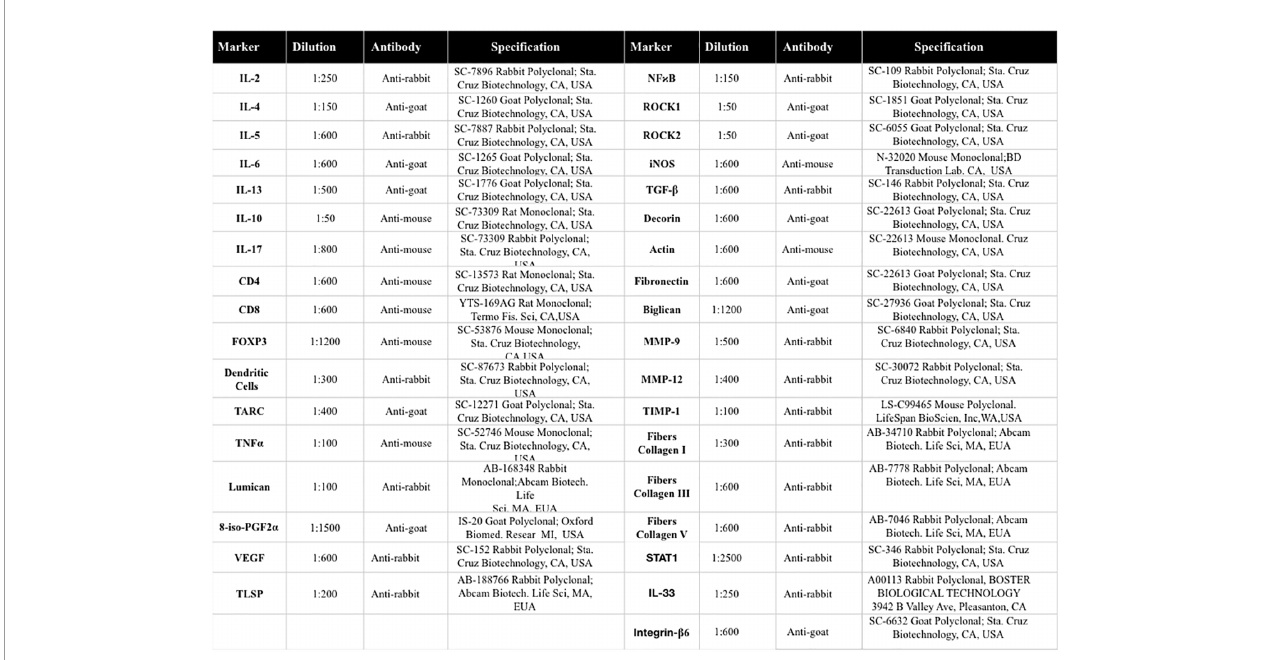
FIGURE 2 | Description of antibodies used for immunohistochemistry